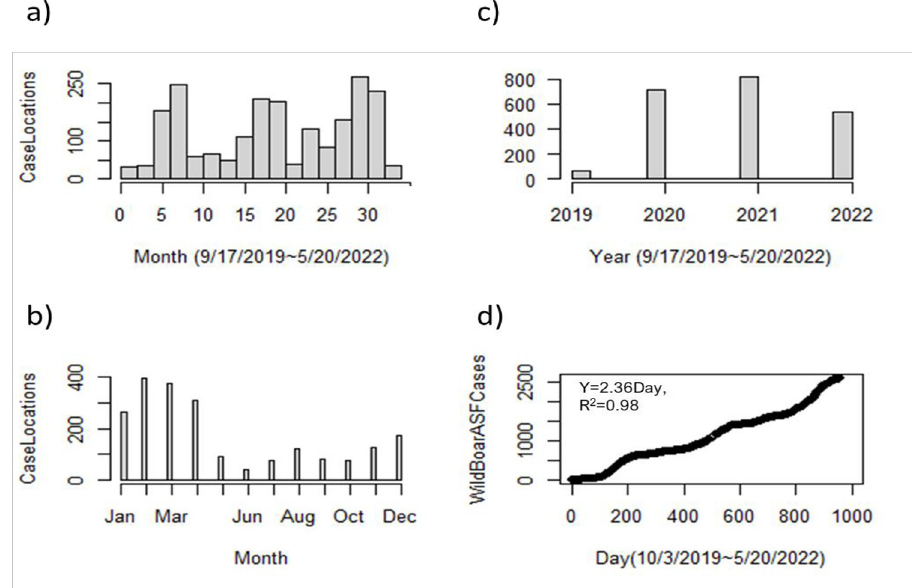
Fig 2. ASFV outbreak locations and cases in different time windows. (a) A frequency plot of ASFV records in 33 months, (b) a frequency plot with respect to months (Jan to Dec), (c) a frequency plot with respect to year since the first confirmed case, and (d) the daily growth of ASFV cases in wild boar since October 3 rd , 2019 to 20 May 20 th , 2022 (1275